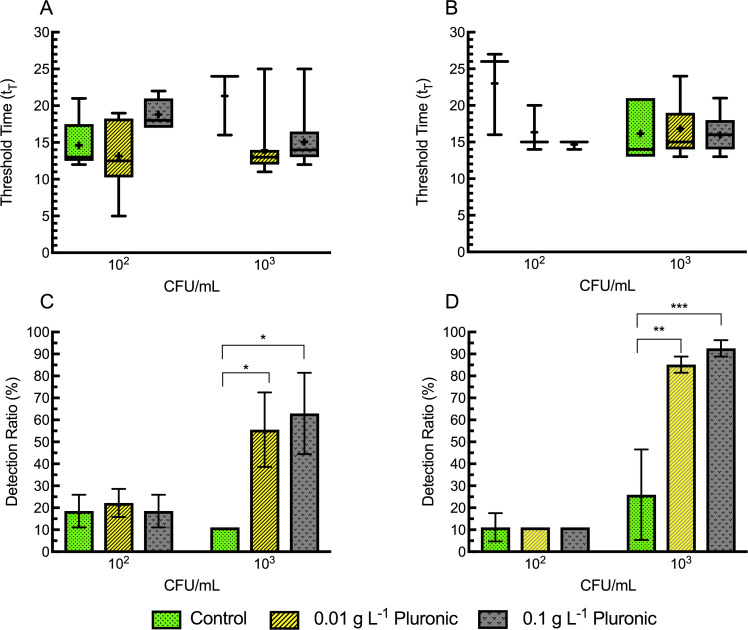
LAMP assay sensitivity of electroflotation treated samples with pluronic F-68.LAMP threshold times (tT) after 15 min high turbulence (A) or 20 min low turbulence (B) EF with the addition of 0.0 (control), 0.01 and 0.1 g L-1 pluronic to EF treatments. In (C; high turbulence) and (D; low turbulence), each bar represents the mean detection ratio from 27 assays conducted on samples from 3 replicated EF treatments. (9 assays/ treatment, n = 3 for each treatment). Treatments significantly different than controls are designated with asterisks (*p<0.05, **p<0.01, ***p<0.001). In (C) and (D) error bars are standard errors of the means. For (A) and (B), whiskers are from min to max and means are indicated by +. The box extends from the 25th to 75th percentiles.